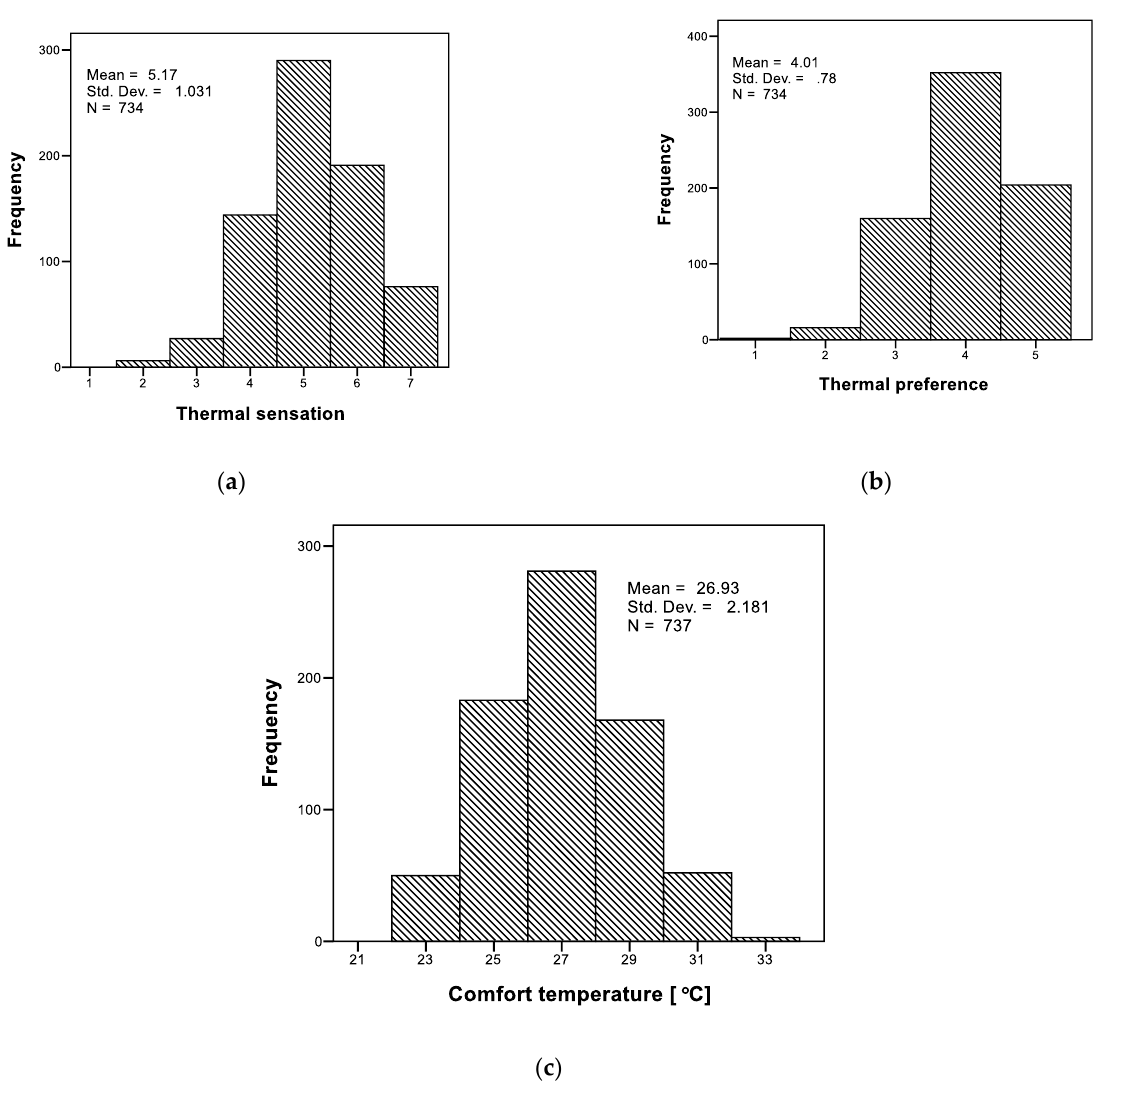
Figure 9. Overall distribution of ( a ) thermal sensation, ( b ) preference, and ( c ) estimated comfort temperature.